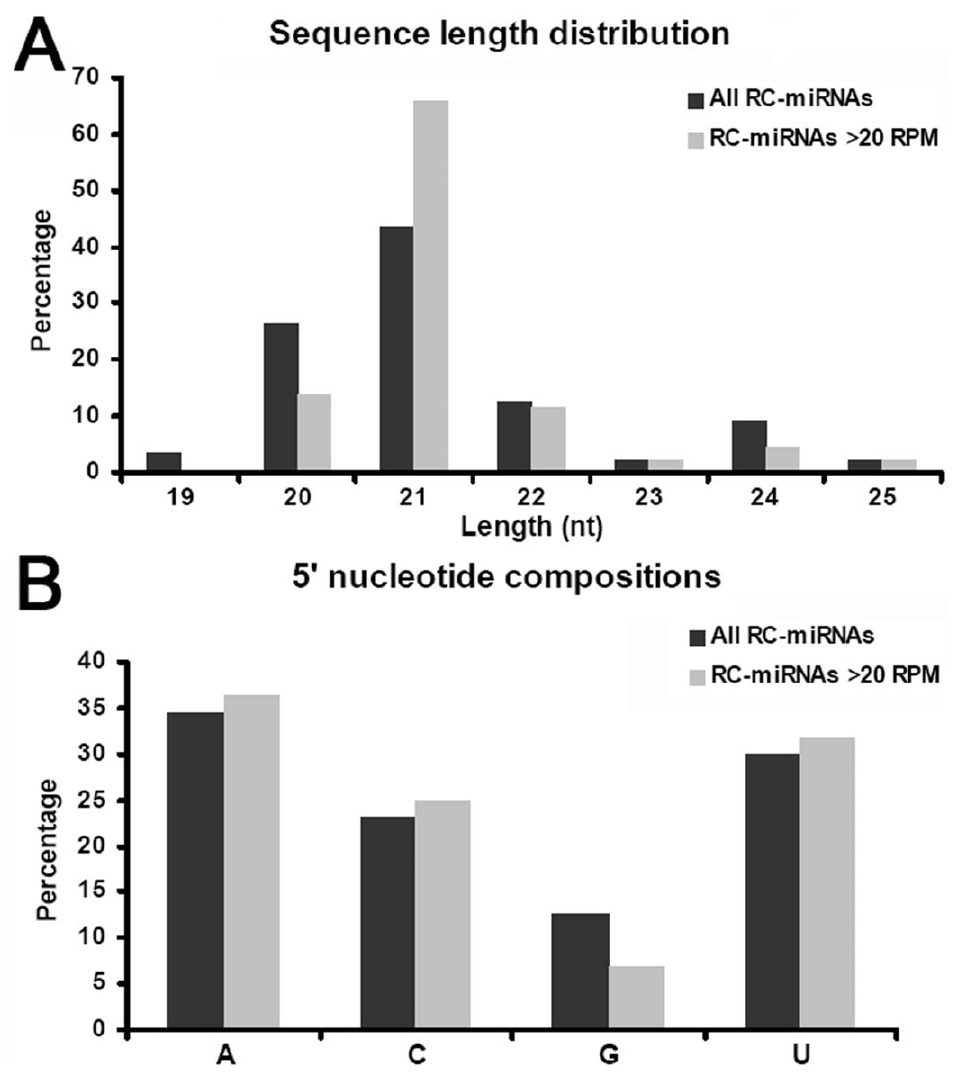
Figure 2. Sequence characteristics of the reverse complementary microRNAs (RC-miRNAs) identified in nine plant species. (A) Sequence length distribution patterns. (B) 5’ terminal nucleotide compositions. For both (A) and (B), all the identified RC-miRNAs (black bars) and the ones with normalized total read counts larger than 20 RPM (reads per million) (gray bars) were analyzed separately.